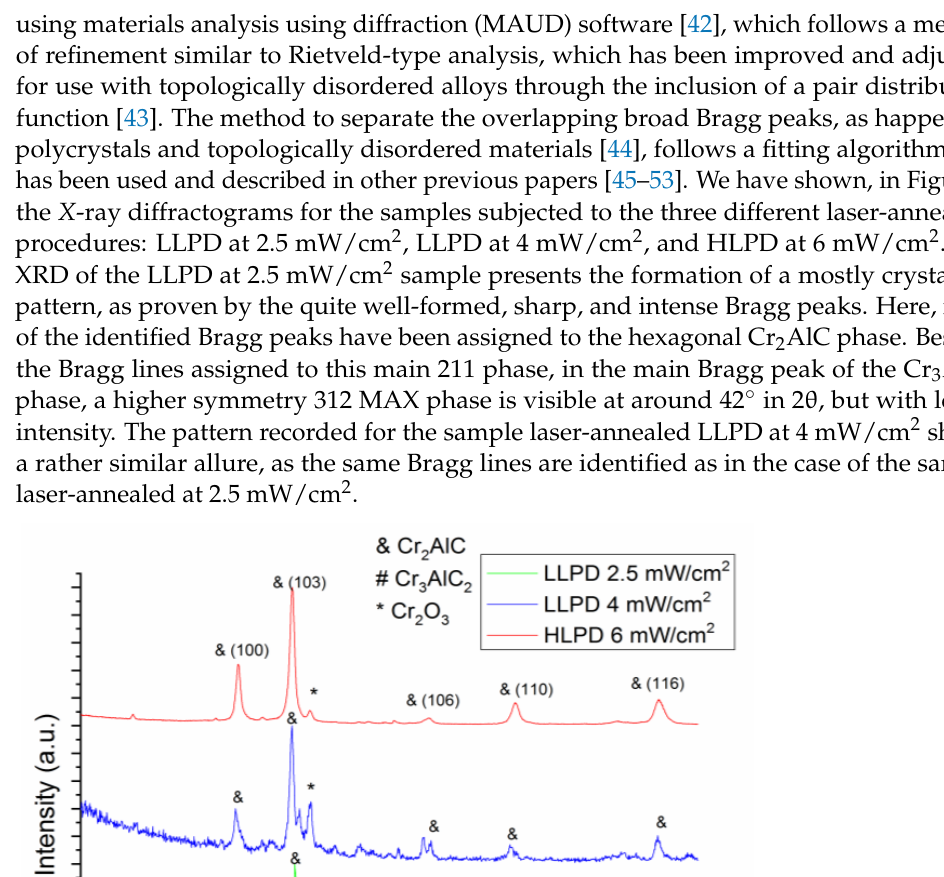
Table 2. The lattice parameters, average crystal size, volume of the unit cell, and microstrain of the 211 MAX phase calculated from the results of MAUD fitting. Sample